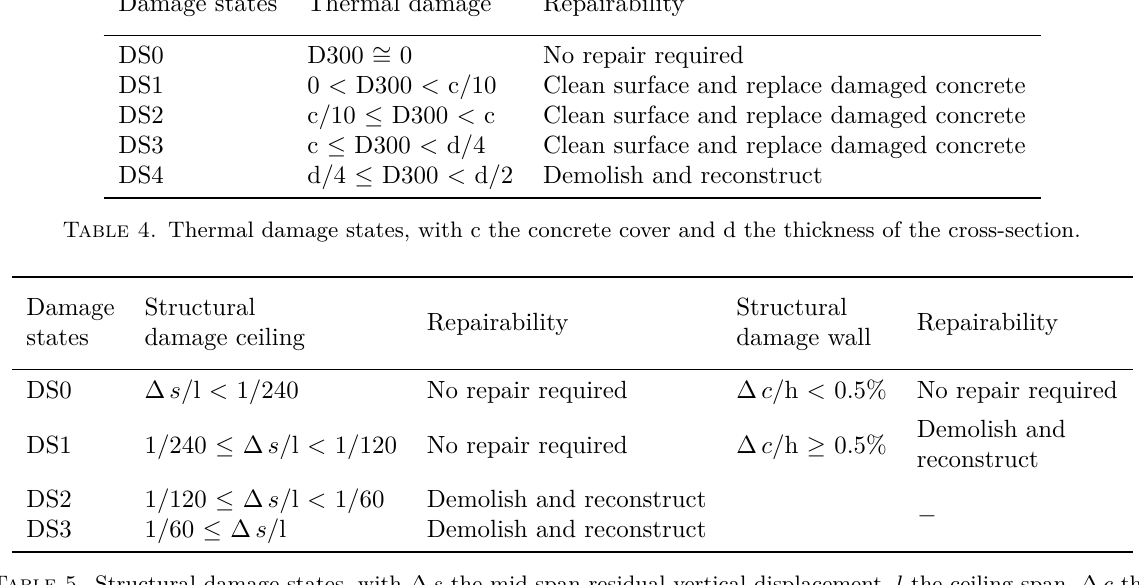
Table 5. Structural damage states, with ∆ s the mid-span residual vertical displacement, l the ceiling span, ∆ c the mid-height residual horizontal displacement, and h half of the wall height.